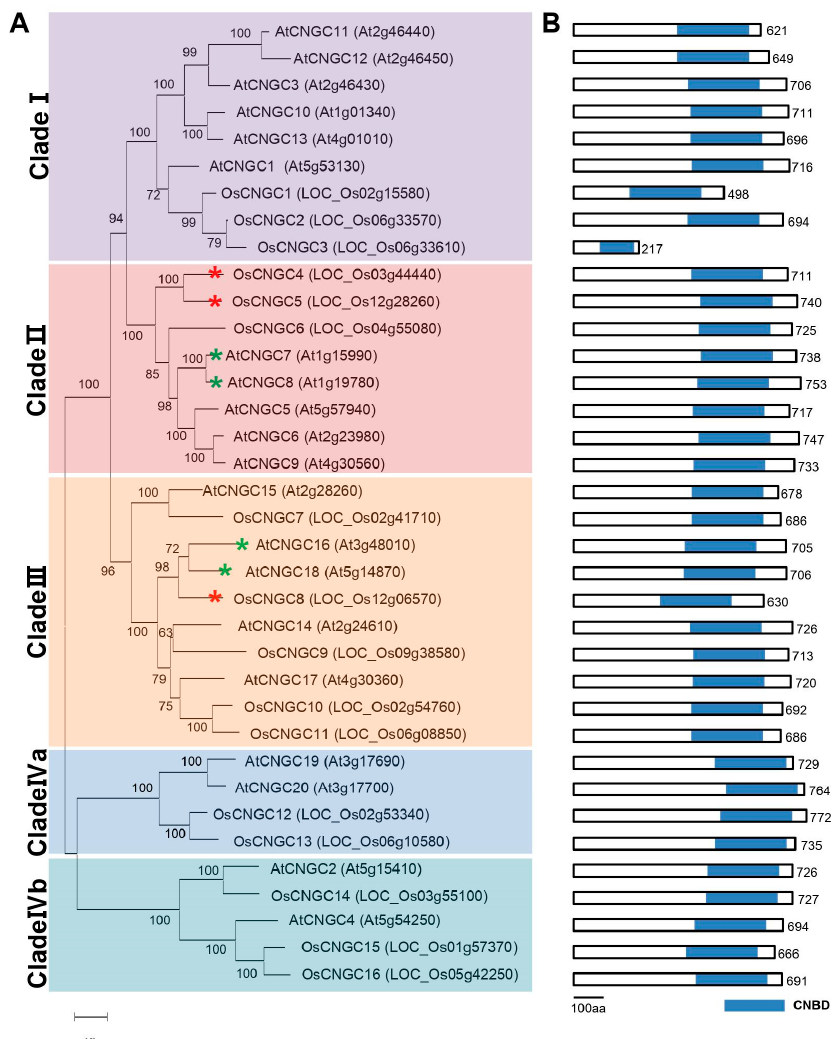
Figure 1. ( A ) The phylogenetic tree was constructed by annotating the protein sequences for each gene by using MEGA7. Red and green asterisks indicate CNGC genes with high expression in pollen in O. sativa (in this study) and A. thaliana , respectively. ( B ) Schematic of the protein structure. The sequence of the protein domain scheme was arranged to be the same as the gene sequence of the phylogenetic tree of ( A ). The length of each CNGC protein is shown on the right; the unit is aa (amino acid). Blue boxes indicate the position and length of the conserved CT-CNBD (cyclic nucleotide-binding domain) of the CNGC family.